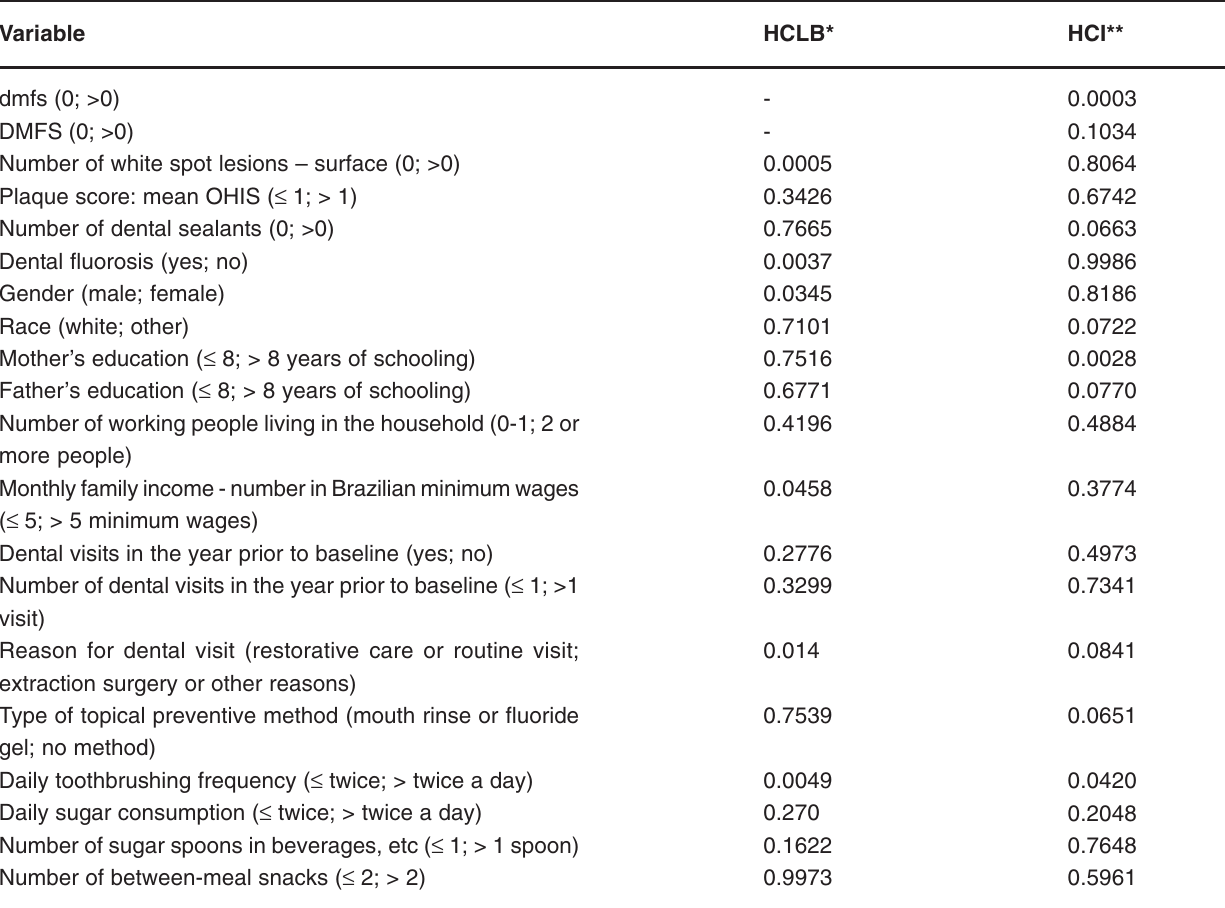
TABLE 1- Association between independent variables and high caries level at baseline (HCLB) or high caries increment (HCI) at final